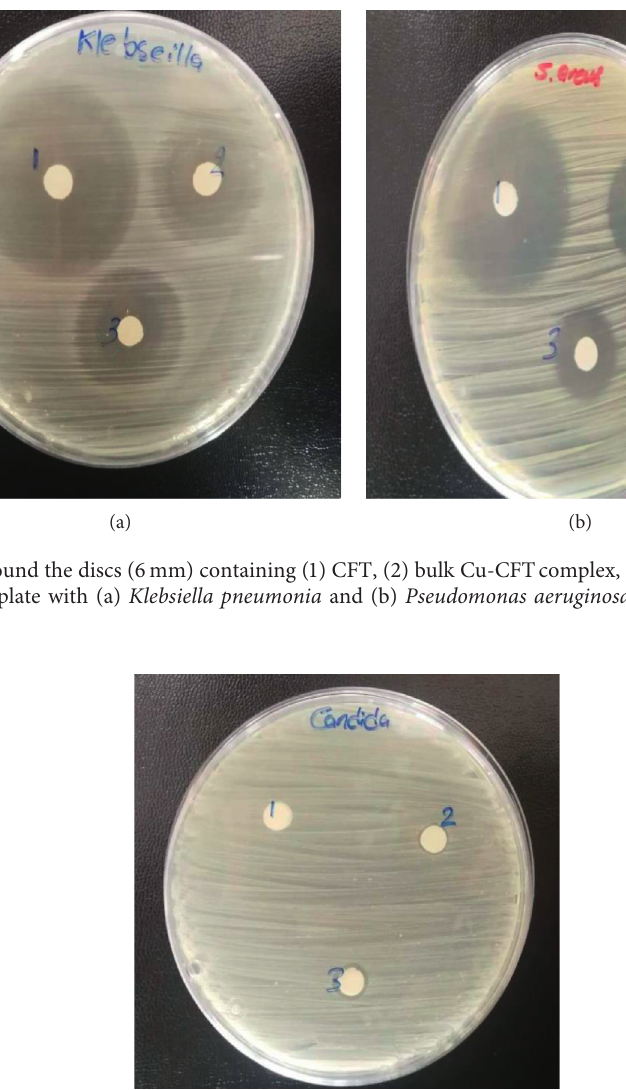
Figure 12: Inhibition zone around the discs (6mm) containing (1) CFT, (2) bulk Cu-CFTcomplex, and (3) nano-Cu-CFTcomplex placed on the surface of an LB-agar plate with Candida albicans .